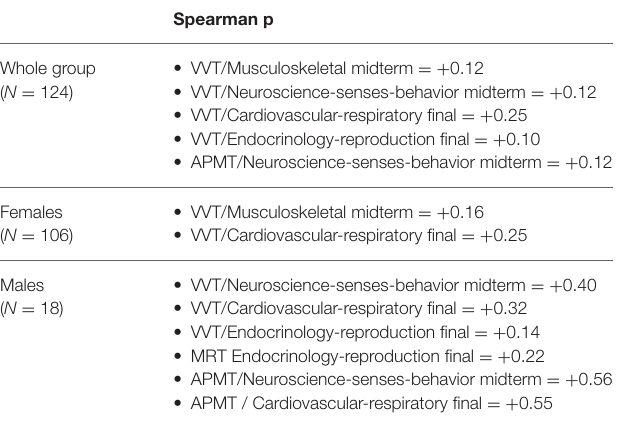
TABLE 3 | Spearman’s entry-level spatial and general reasoning test results and performance on veterinary anatomy practical